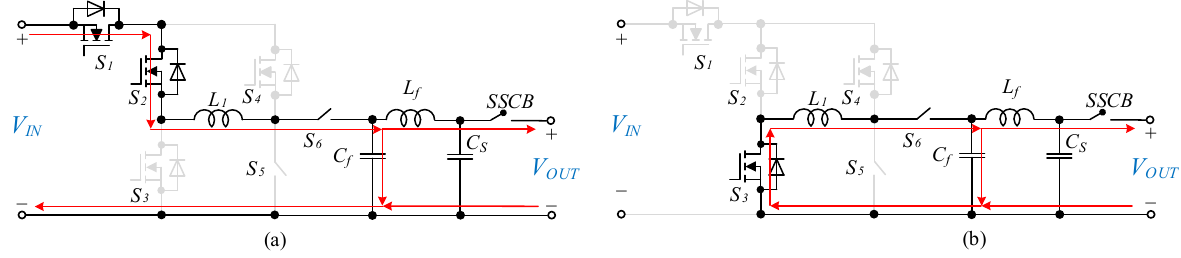
Figure 7. Equivalent circuits of the selected topology in the buck (asymmetrical) mode: ( a ) first operation mode—positive half cycle, and ( b ) second operation mode—positive half cycle.